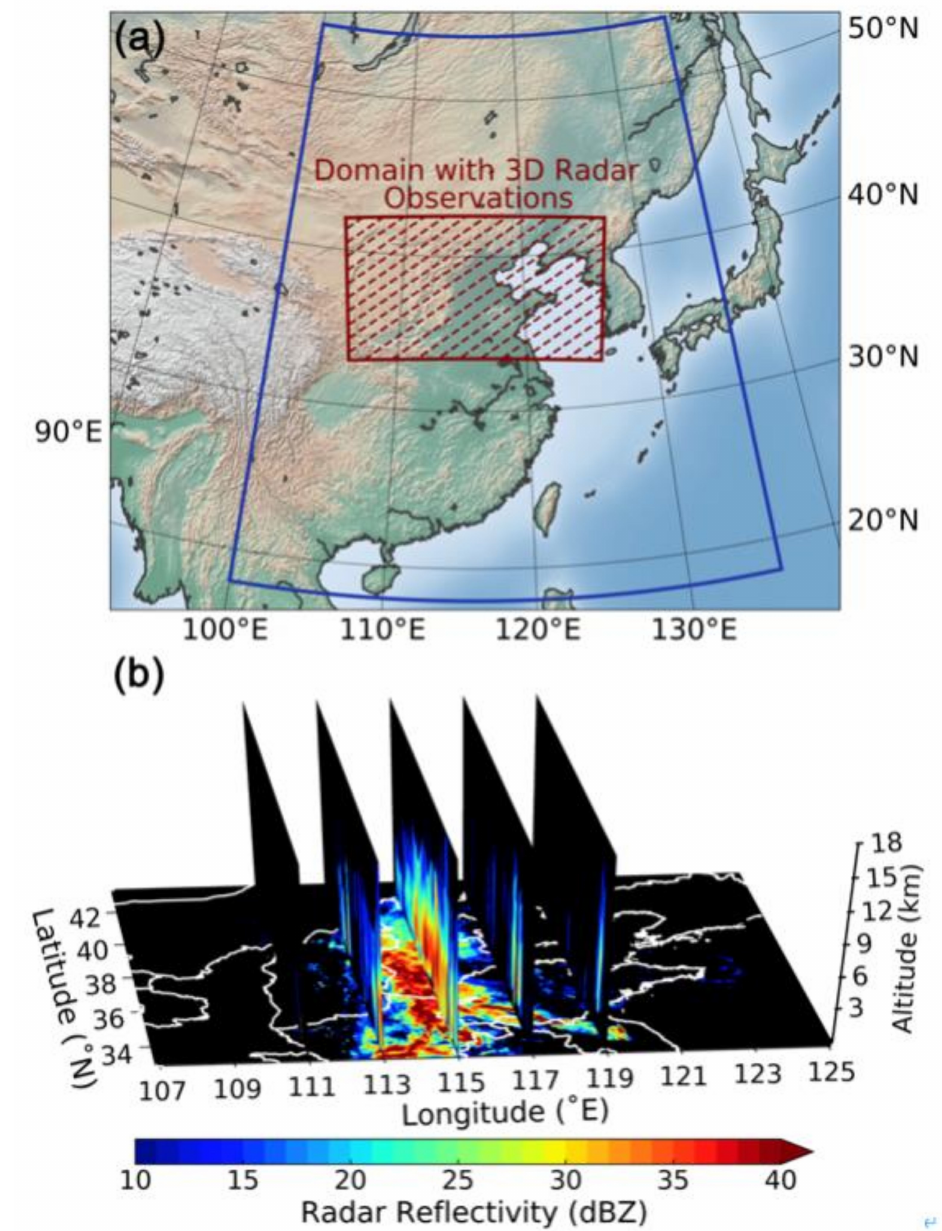
Figure 1. ( a ) Region of interest (bounded by blue lines) in eastern China. The area hatched in red refers to the domain with three-dimensional (3D) radar observations. ( b ) The latitude-vertical cross-sections of radar reflectivity (shaded colors) merged by the Advanced Regional Prediction System at 1130 UTC on 19 July 2016 over northern China, superimposed on the composite reflectivity